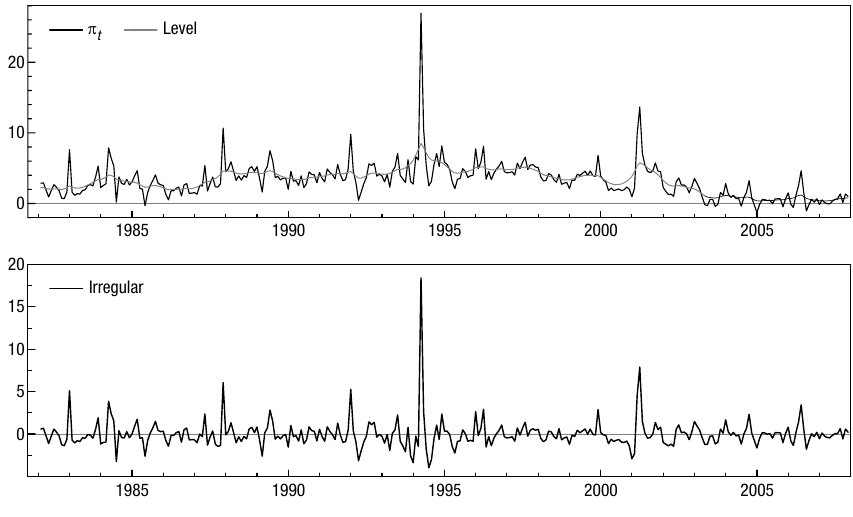
Fig. 2. Level and irregular components of